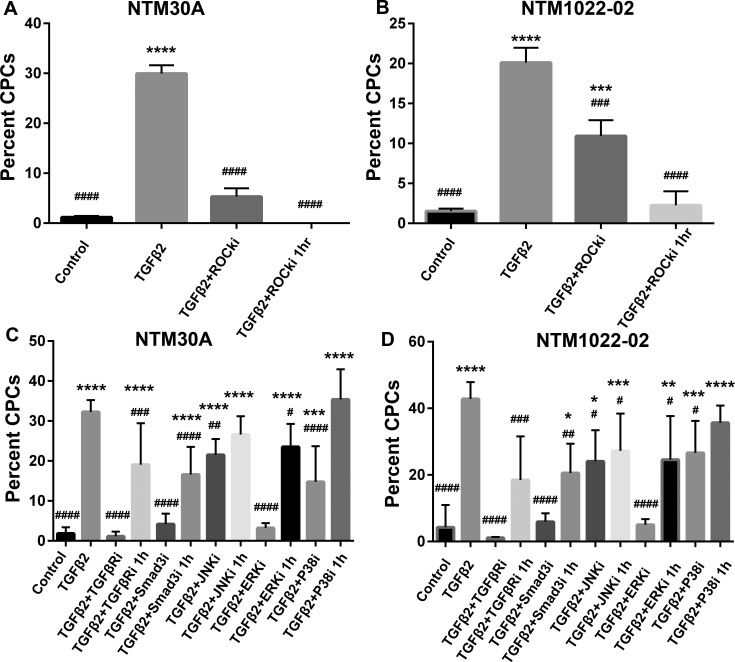
Resolution of CLAN formation in NTM cells by TGFβ pathway inhibitors. NTM cells cultured on glass coverslips (n = 6) were pretreated with TGFβ2 for 10 days, followed by 1-hour treatment of the indicated inhibitors. Some cells were also cotreated with TGFβ2 and the indicated inhibitor for 10 days as a positive control. Percentage of CPCs was compared using 1-way ANOVA with Dunnett's multiple comparisons post hoc test. (A, B) NTM cells treated with the ROCK inhibitor. (C, D) NTM cells treated with the other inhibitors. Columns and bars: means and SEM. *P < 0.05 for group of interest versus control; **P < 0.01, ***P < 0.001, ****P < 0.0001, and #P < 0.05 for the group of interest versus TGFβ2; ##P < 0.01, ###P < 0.001, and ####P < 0.0001. TGFβRi, TGFβ receptor inhibitor (SB431542; 5 μM); SMAD3i, Smad3 phosphorylation inhibitor (SIS3; 10 μM); JNKi, JNK pathway inhibitor (SP600125; 10 μM); ERKi, ERK pathway inhibitor (U0126; 25 μM); P38i, P38 pathway inhibitor (SB203580; 5 μM); ROCKi, ROCK pathway inhibitor (Y27632; 10 μM).